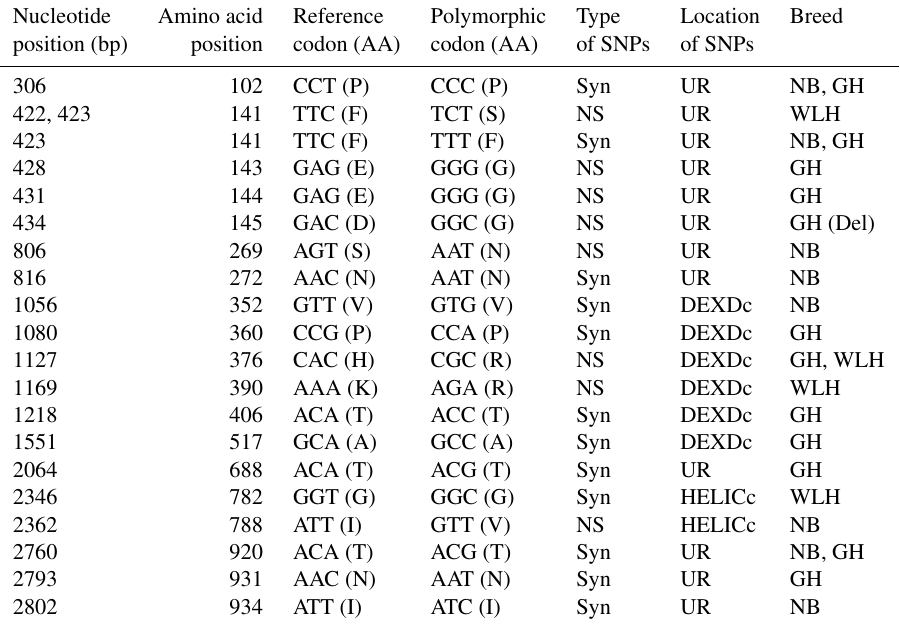
Table 4. Polymorphisms in the MDA5 gene of different chicken breeds. Nucleotide Amino acid